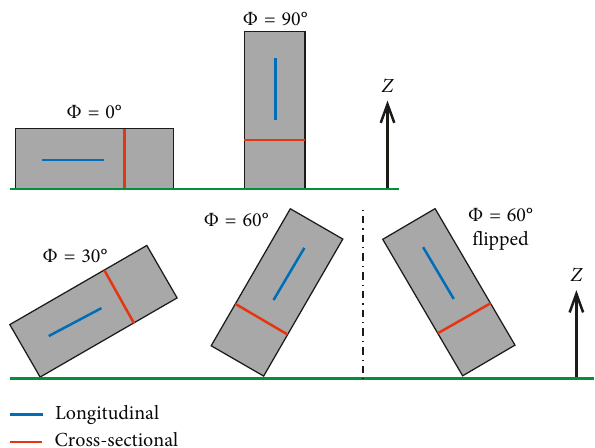
Figure 2: Configurational similarities in longitudinal and cross- sectional test samples.